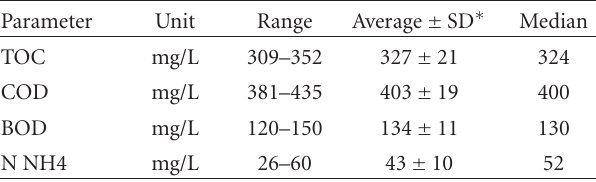
∗ SD: standard deviation; number of measurements n = 16; time- dependent variation of parameters value was caused by unstable composi- tion of leachate. Table 4: Characteristic of “new” landfill leachate (nondiluted). Parameter